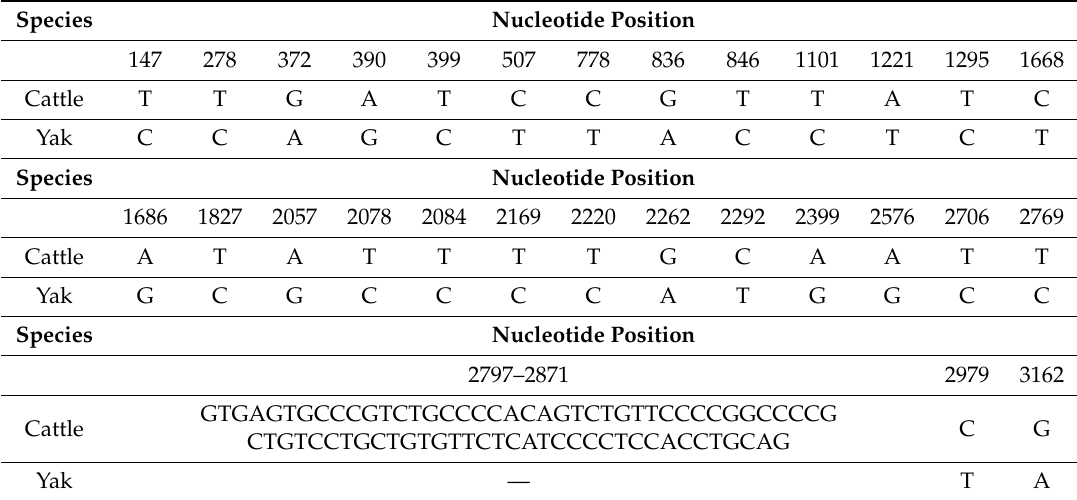
Table 4. Nucleotide di ff erences in the coding sequences of bovine and yak KDM4B genes. Species Cattle